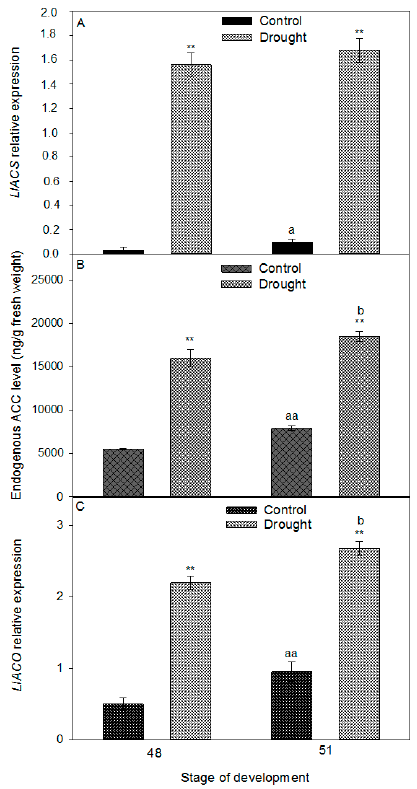
Figure 8. Expression analysis of ethylene (ET) biosynthesis genes, LlACS ( A ), and LlACO ( C ), (related to LlACT ) and endogenous level of ET precursor-ACC in floral abscission zone (AZ) of Lupinus luteus